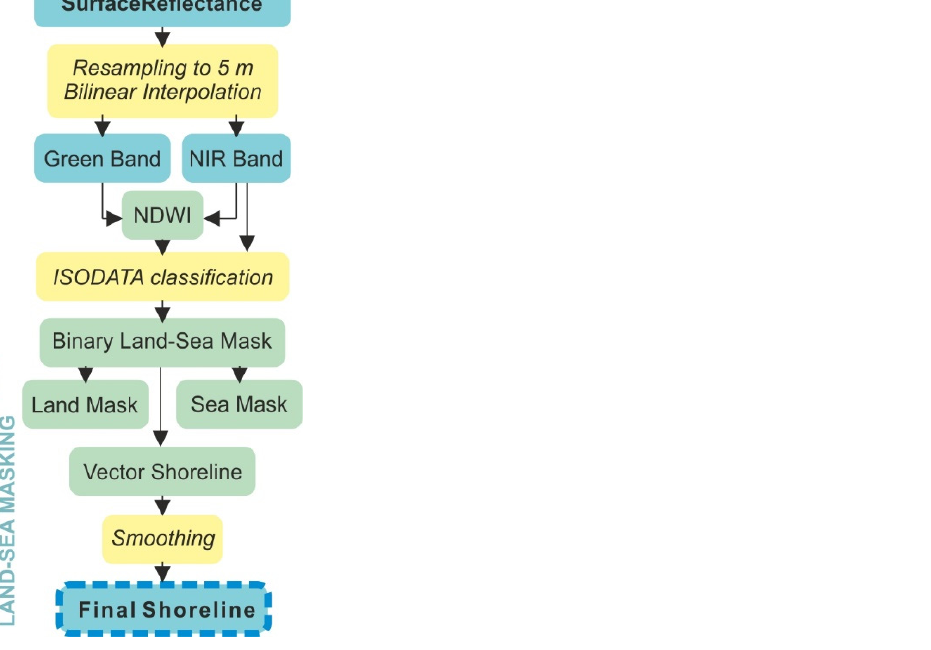
Figure 3. A flowchart of the land-sea masking and shoreline derivation procedure used in this study.